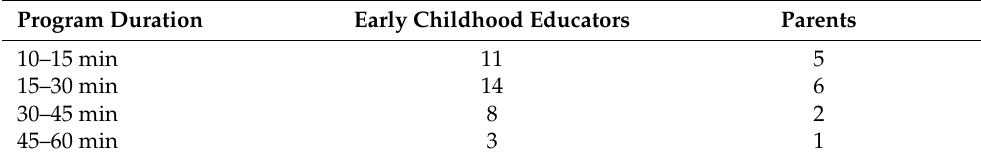
Table 4. Participant responses regarding preferred duration of program delivery.